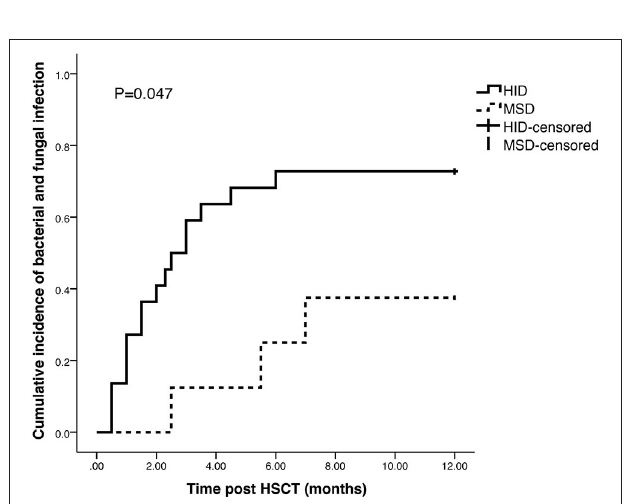
FIGURE 3 | Cumulative incidence of bacterial and fungal infection in HID and MSD cohort.